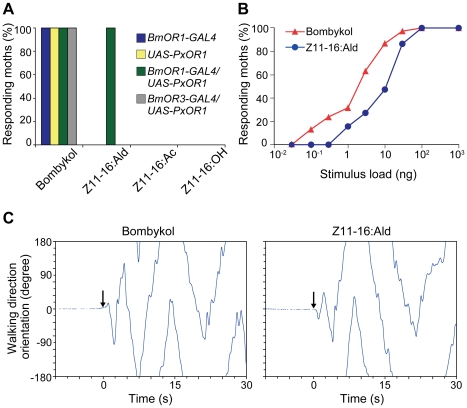
PxOR1-expressing males exhibit pheromone-orientation behavior in response to Z11-16:Ald stimulation.(A) Behaviorally responding percentages of male moths of the indicated genotype. The moths were exposed to 100 ng of bombykol or the pheromones of P. xylostella. The display of wing flapping was used as the criterion for a behavioral response to pheromone. The numbers of samples are as follows: BmOR1-GAL4 (n = 13), UAS-PxOR1 (n = 15), BmOR1-GAL4/UAS-PxOR1 (n = 38), BmOR3-GAL4/UAS-PxOR1 (n = 10). (B) Dose-dependent increase in the percentages of moths that responded to bombykol or Z11-16:Ald (n = 22–38). The sensitivity of PxOR1-expressing males to Z11-16:Ald was significantly lower than that to bombykol; GLM, P<0.001. (C) Walking direction orientation in a BmOR1-GAL4/UAS-PxOR1 male moth after a single pulsed stimulation (500 ms) of 40 ng of bombykol (right) or Z11-16:Ald (left) to antennae. Stimulus onset (at t = 0) is indicated by arrows, an angle of zero degrees indicates the initial forward direction.